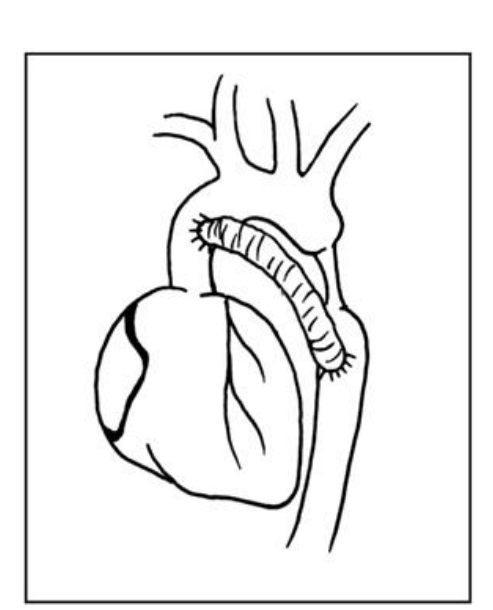
Fig. 2 - Desenho esquemático da operação realizada